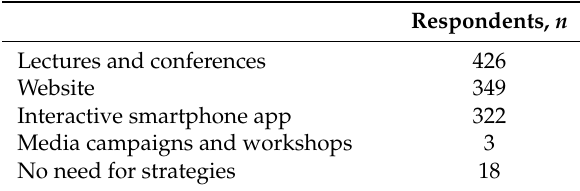
Table 3. Most commonly suggested strategies to educate healthcare providers on drinking